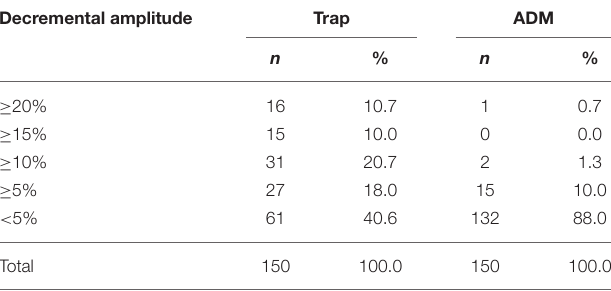
TABLE 1 | RNS decremental amplitude and frequency in ALS patients. Decremental amplitude